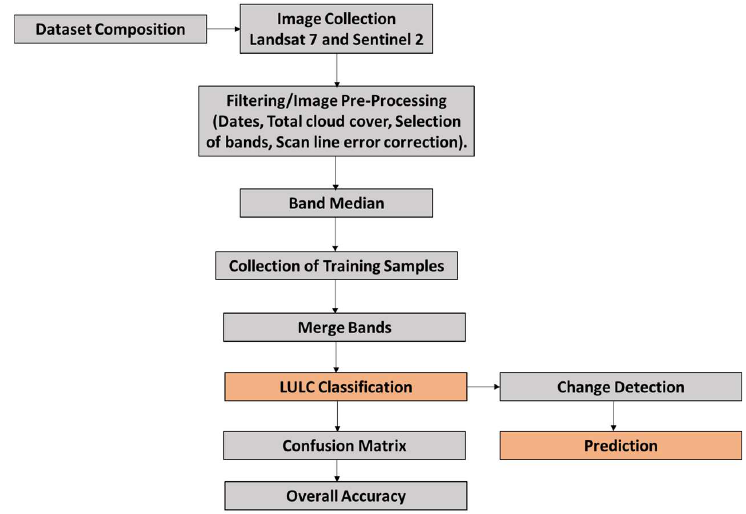
Figure 2. Methodology flow chart.